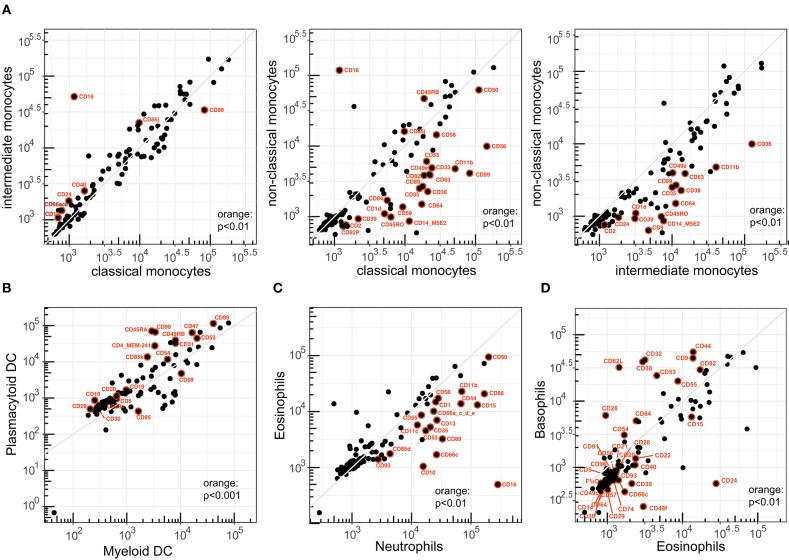
Correlation of CD1–CD100 expression levels between related innate leukocytes. Pairwise analysis of expression levels (ABC) between (A) classical, intermediate, and non-classical monocytes; (B) myeloid DC and plasmacytoid DC; (C) neutrophils and eosinophils; and (D) eosinophils vs. basophils. CD41 and CD42b were excluded from the plots in (B–D). Both markers were not expressed on any granulocyte or DC cell type (ABC < 2 × 102).